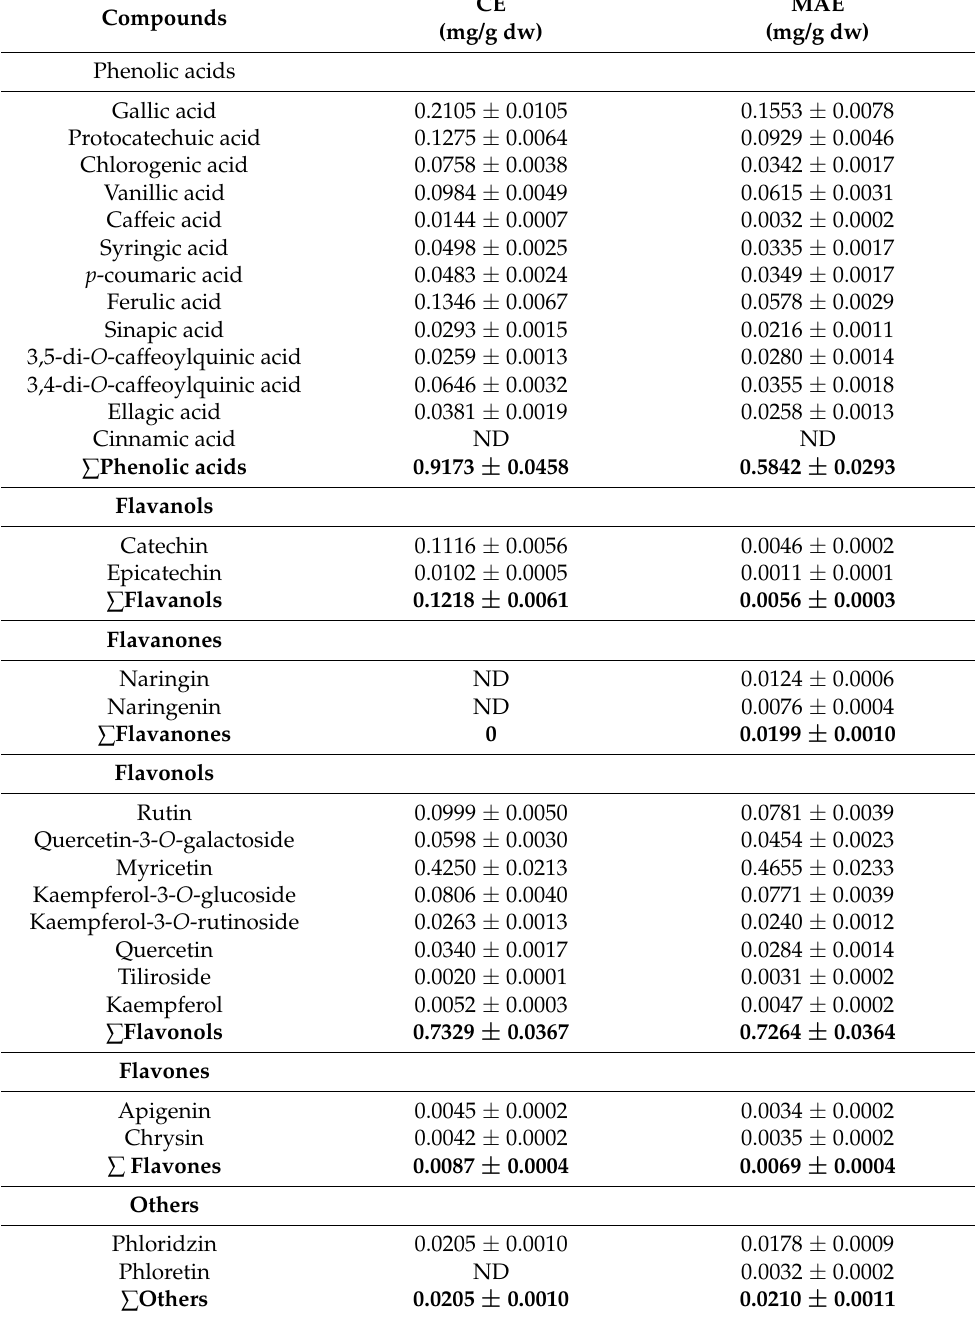
Table 2. Content of the identified phenolic compounds in S. ramosissima extracts prepared by CE and MAE. Results were expressed as mean ± standard deviations (mg of compound/g